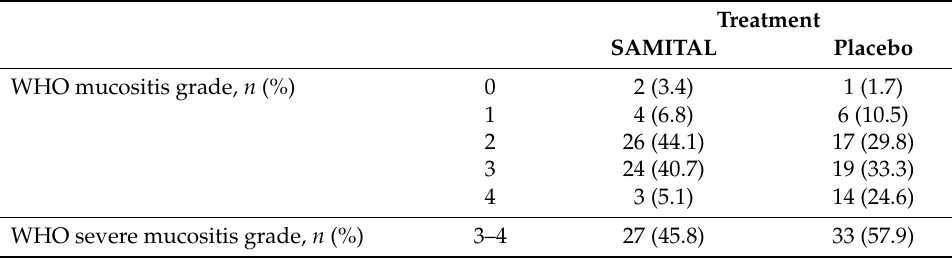
Treatment SAMITAL Placebo